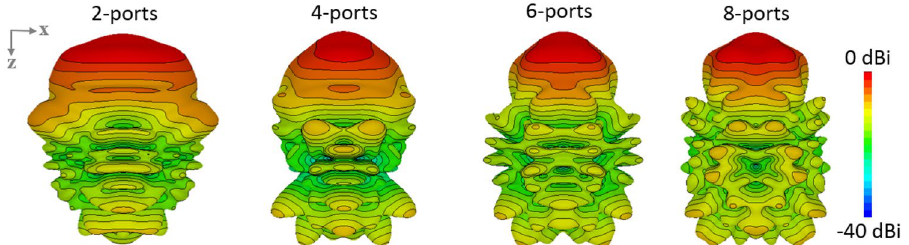
Figure 4. Beam shaping in response to the simultaneous excitation of 2, 4, 6 and 8 ports.